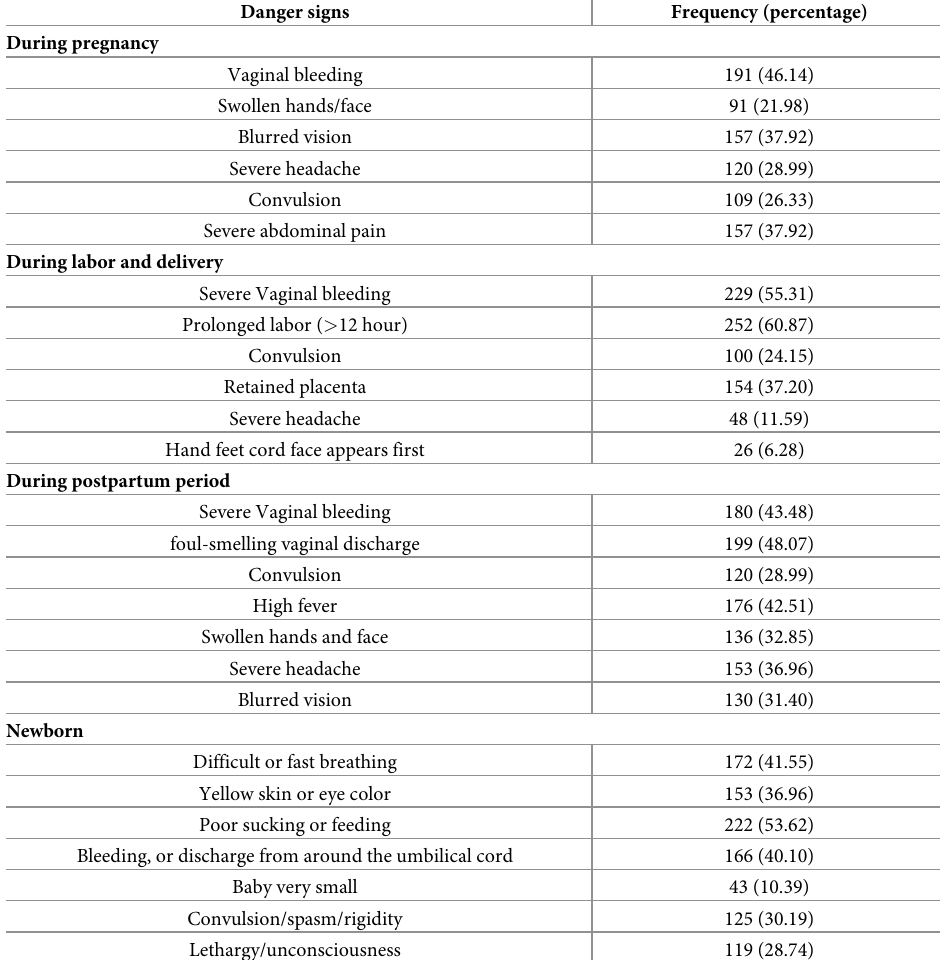
Table 3. Items used to measure knowledge of danger signs during pregnancy, labor and delivery, postpartum, and in newborns among pregnant women attending antenatal care service at North Shewa zone public hospitals, Oro- mia region, central Ethiopia, 2021 (n =